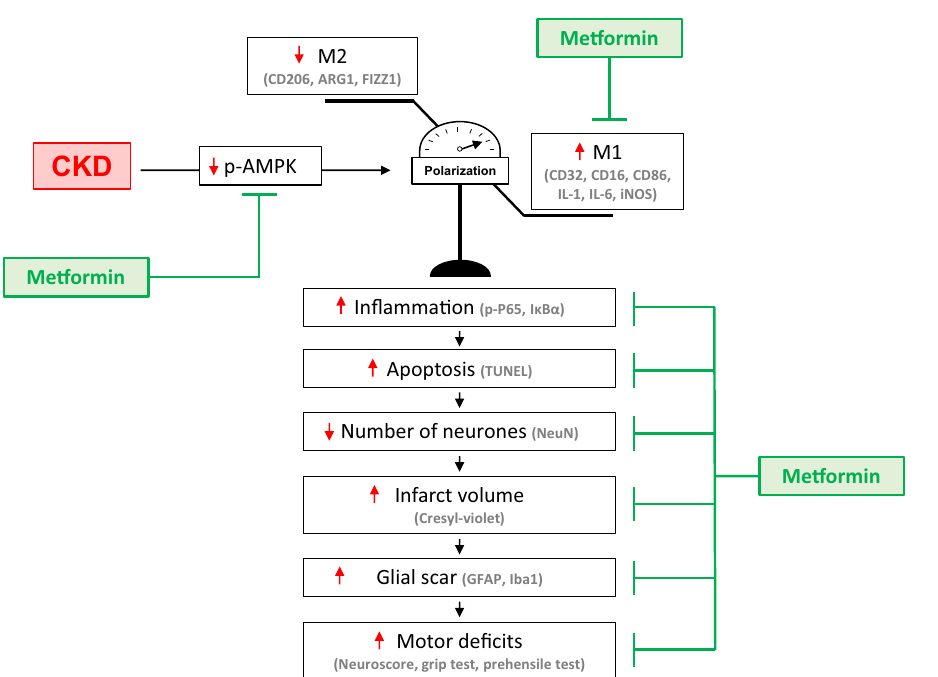
Figure 6. Hypothetical scheme of the mechanisms by which metformin prevent ischemic stroke damage in non-diabetic mice with CKD. In brain ischemic lesions of non-diabetic CKD mice, AMPK activity, which is known to block microglia/macrophages M1 polarization, is impaired. The recruited microglia/macrophages consequently display increased M1 and reduced M2 polarization. The subsequent inflammation may be responsible for the elevated apoptosis, increased infarct volumes and poorer functional outcomes. A 5-week course of pre-conditioning with metformin rescued the activation of AMPK in mice with CKD. This effect is associated with a significant decrease of macrophage/microglia transition towards the M 1 phenotype, as shown by the decreased expression of the M 1 markers CD16, CD32, and CD86. Metformin-induced AMPK activation blocks NFκB activation and the subsequent release of pro-inflammatory cytokines such as IL-1β. This decrease in inflammation may be responsible for less brain-cell apoptosis, thus reducing the cortical infarct volume and subsequent neurobehavioral